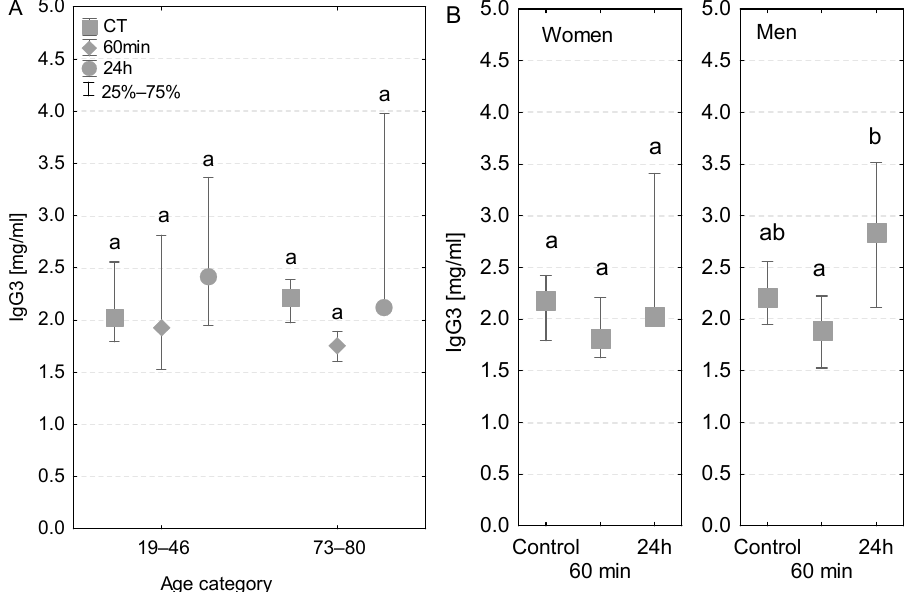
Figure 7. Serum IgG3 concentration (median ± quartile deviation; 25th and 75th percentiles). ( A ) Comparison based on the age of patients: 19–46 years and 73–80 years. ( B ) Comparison based on the sex of the patients. CT: measurement before the onset of CPB; 60 min: measurement at 60 min of the CPB onset; 24 h: measurement at 24 h after the onset of CPB. Values with different letters (a, b) indicate significant differences within the age or sex category (Friedman’s test or Mann–Whitney U test; p < 0.05).